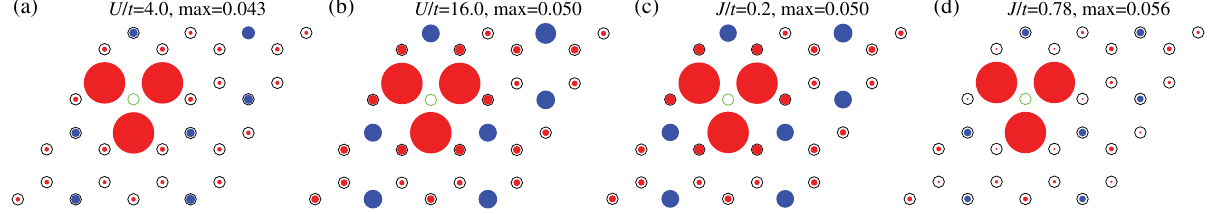
i Þ S j Þi in the DMRG ground state projected into sector with center-of-mass momentum FIG. 19. Spin-spin correlation function h S z ð z ð Γ and C − i π = 3 Þ . Blue is positive, red negative, and disk radius is proportional to amplitude. Site i is fixed at 6 rotation eigenvalue exp ð green circle, while every bond i , j is averaged over translations and rotations to reduce statistical error by increasing the number of sampled observable values in MC runs. “ max ” labels absolute amplitude of largest shown disk. All four parameters are chosen within the CSDW or SCCL phase: (a),(b) Hubbard model, (c),(d) t - J